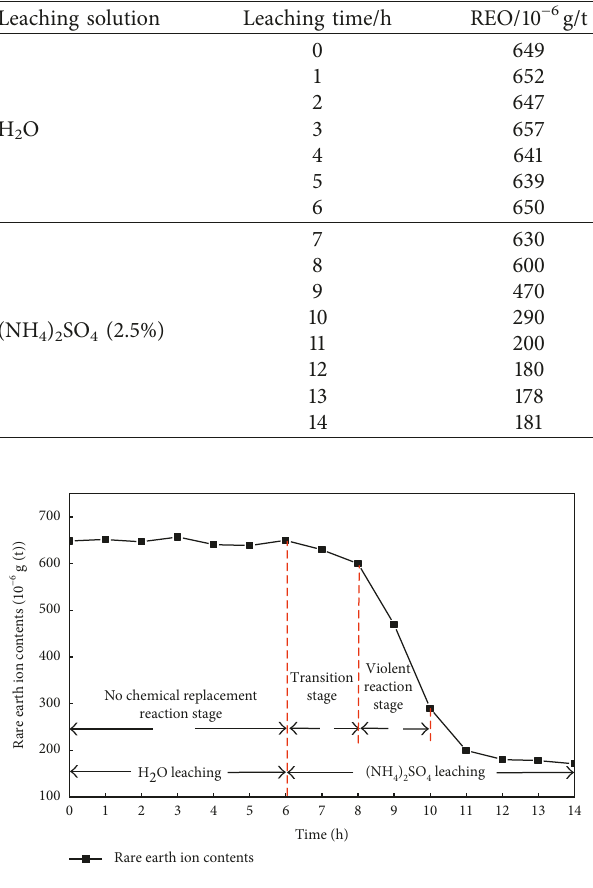
Figure 6: REO changing curve in the leaching experiment process.